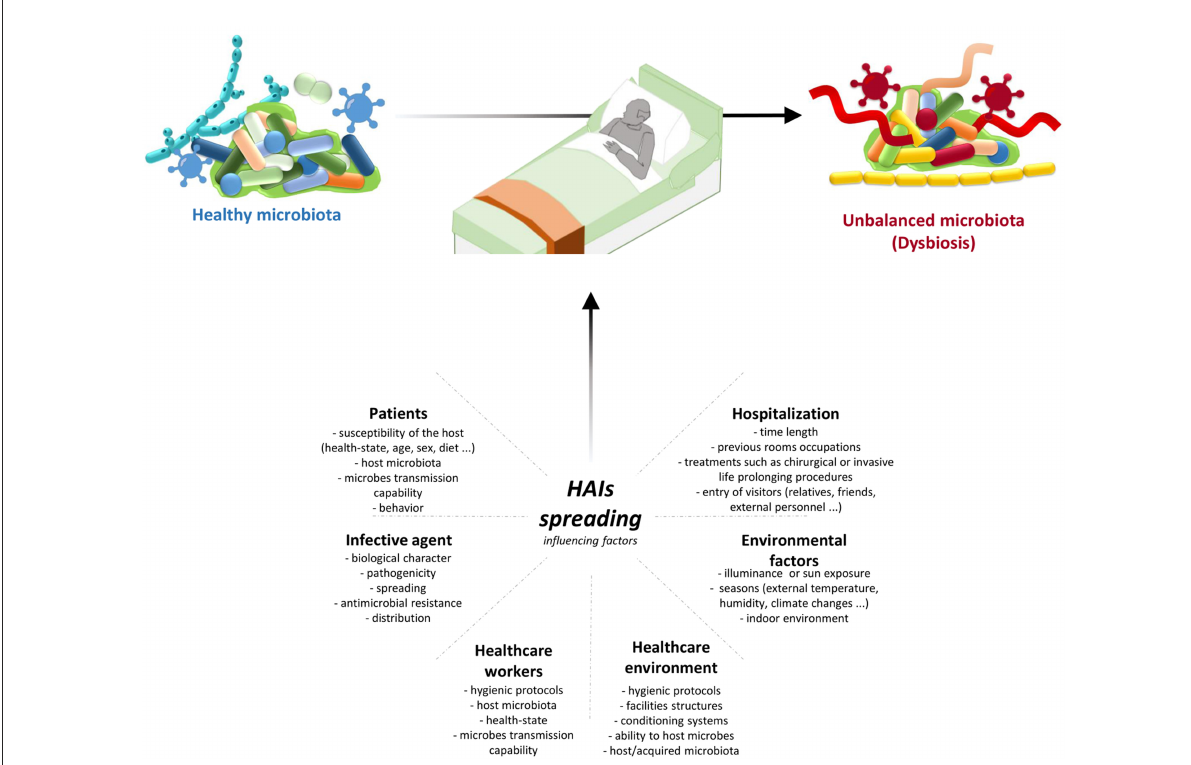
FIGURE3 HAIs spreading influencing factors. HAIs are mainly due to the microbiota transition from an healthy state to dysbiosis. This alterations are caused by different factors: hospitalization conditions and reason for admission; both external and internal environmental factors; HE hygienic condition and HE ability to host/acquire microbes; ability to transmit microbes by the HCWs, their healthy condition, and their propensity to follow hygienic procedures; infective agent itself; and patients healthy state and their behaviour. Therefore it is important a multifaceted approach to manage all these factors and thus HAIs spreading. HAIs, healthcare-associated infections; HCWs, healthcare-workers; HE,